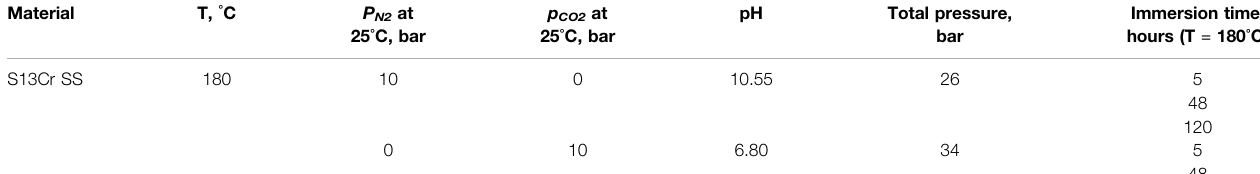
TABLE 3 | Test matrix for corrosion tests under different conditions.